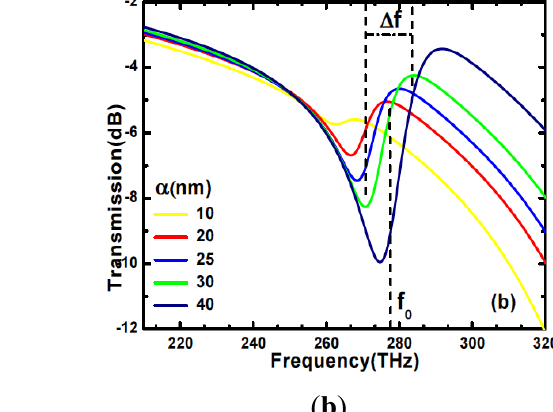
Figure 3. ( a ) Bright and dark mode resonances for different values of length asymmetry α . ( b ) Details of the dark mode change on asymmetry.  f and f